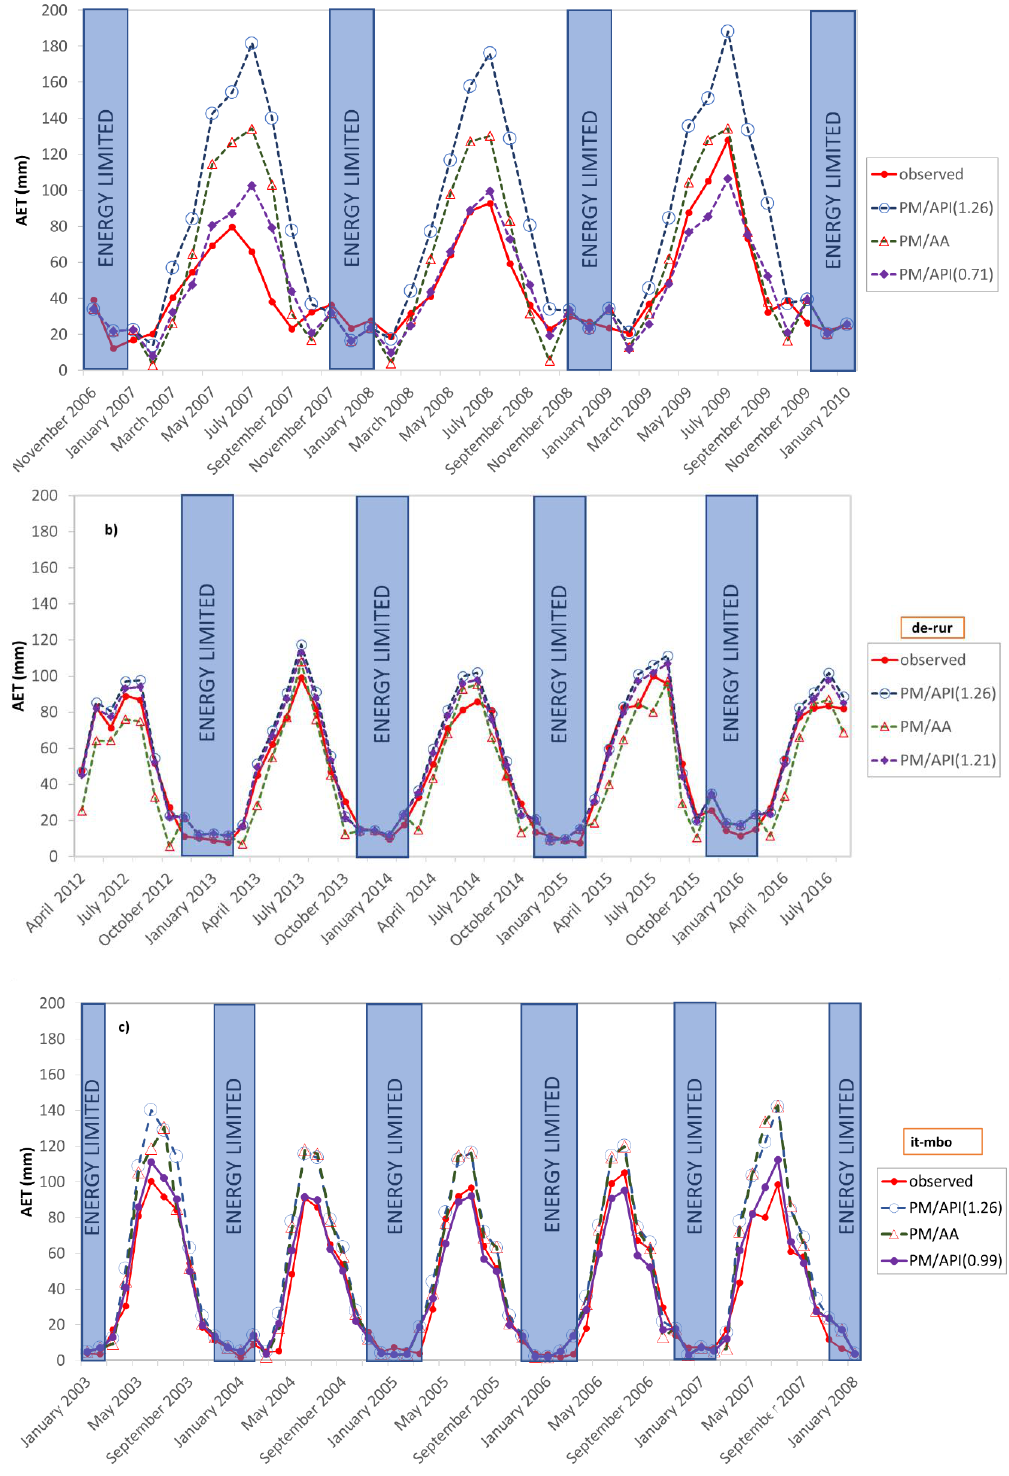
Figure 8. Monthly patterns for AET computed by the empirical and threshold approaches at Sister site ( a ), Rollesbroich site ( b ), and and Bondone mountain ( c ). The energy limited period has been highlighted where the threshold approaches have a larger fitting. (PM / AA = Penman / advection-aridity threshold model; PM / API(1.26) = Penman / APIcorrectedpotentialevapotranspirationthresholdmodel, with α = 1.26; PM / API( α CAL ) = Penman / API corrected potential evapotranspiration calibrated threshold